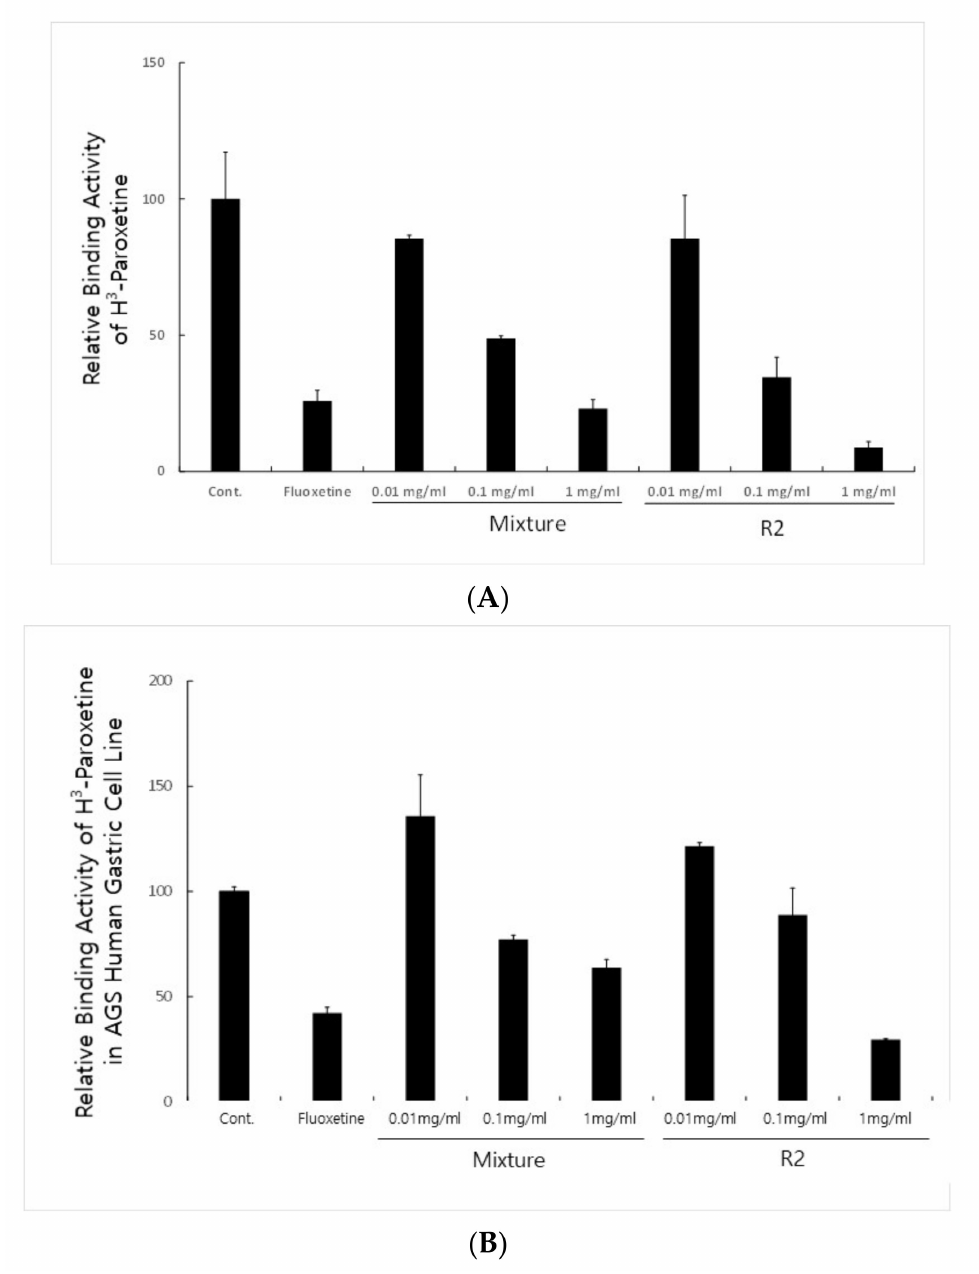
Figure 5. Purified fractions of P. eryngii showed inhibition activity of serotonin receptor binding. ( A ) The receptor binding assay was performed with the XAD-16 column eluates and R2 fraction of HPLC separation of P. eryngii. Fluoxetine was used as a positive control, and the negative control was buffer. The concentration of the XAD-16 column eluates and the R2 fraction was used from 0.01 mg/mL to 1 mg/mL. The experimental procedure and receptor protein used in this assay were the same as in Figure 4. The mixture indicates that the XAD-16 column eluates and R2 is F2P1R2. ( B ) Additionally, a receptor binding assay was performed with the AGS cell line, which is a gastric cancer cell line. The overall experimental procedure was the same as the receptor binding assay performed with the 5HT-1A protein in addition to using the cell instead of the